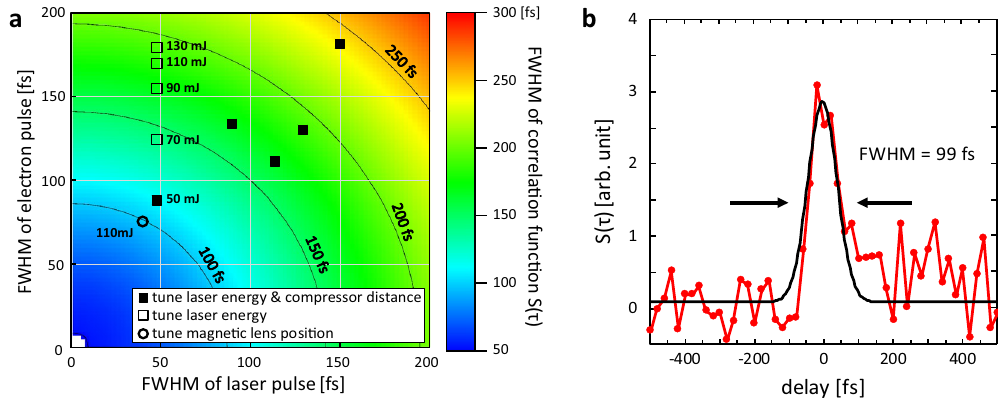
Figure 2. Pulse width measurement based on ponderomotive scattering. ( a ) Electron pulse width inferred from the laser pulse width and the correlation function. The colour scale shows the FWHM of the function S(τ) and maps the result of calculating Eq. (6) using τ l and τ e as variables. ( b ) Cross correlation of the laser pulse and electron pulse at the most compressed condition in ( a ) (open circle). The laser pulse width τ l used for the measurement was 17 fs (40 fs at FWHM), and τ s was 42 fs (99 fs at FWHM).